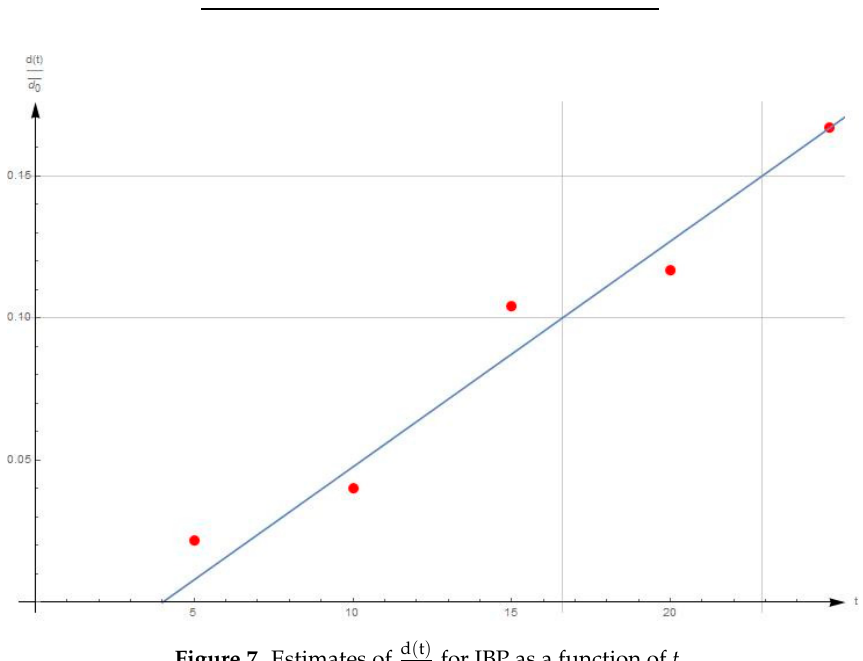
Figure 7. Estimates of (cid:2914)((cid:2930))